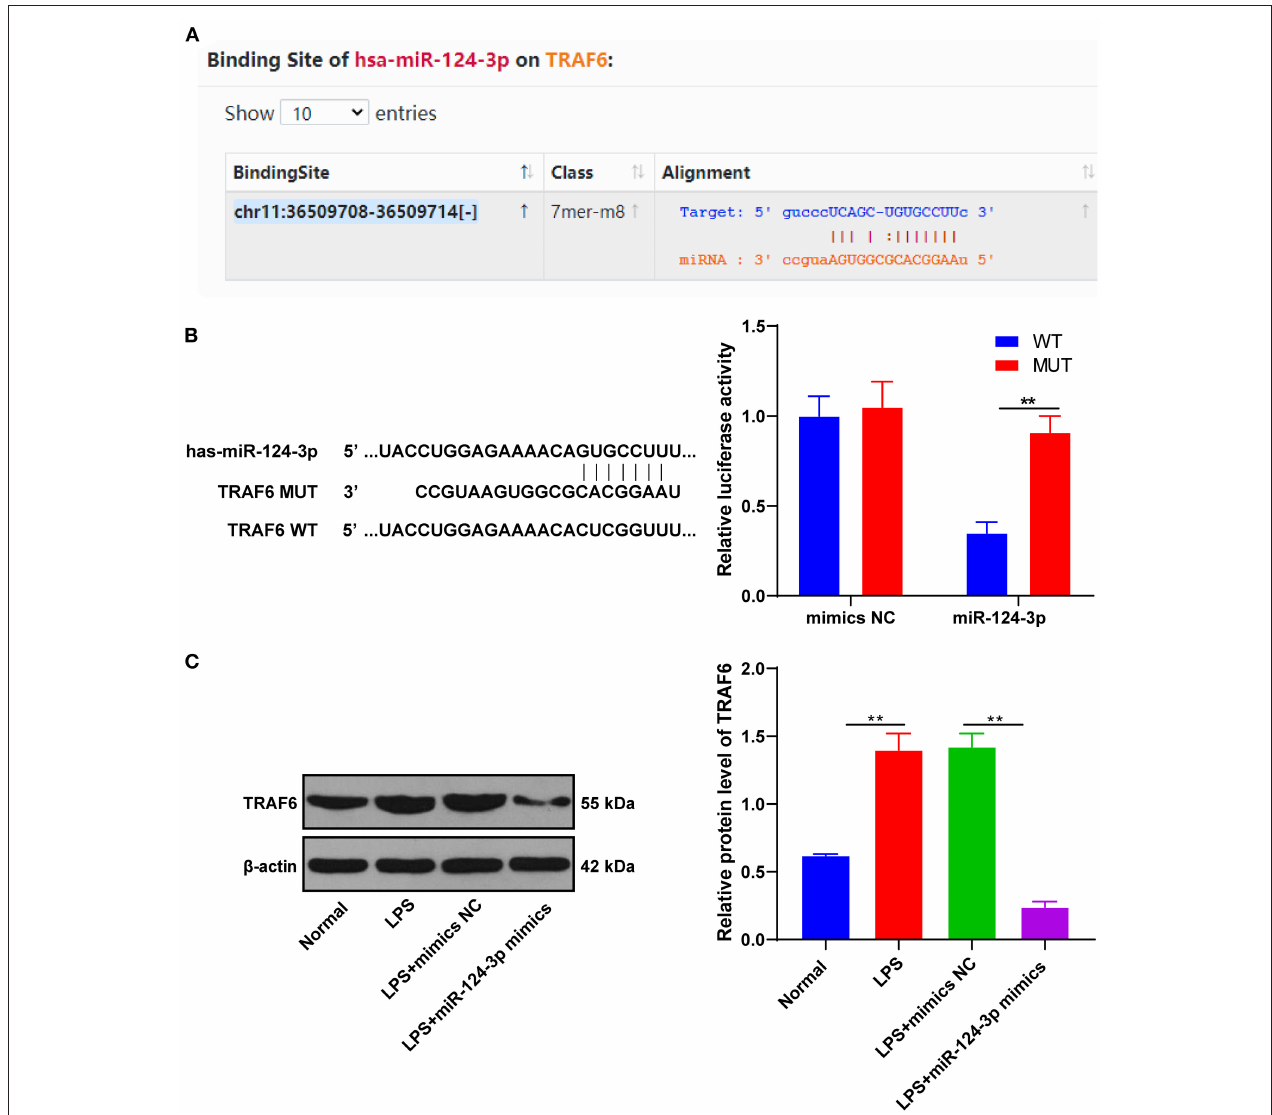
FIGURE 3 | miR-124-3p-targeted TRAF6. (A) The binding site between miR-124-3p and TRAF6 was predicted by Starbase; (B) The relative luciferase activity of miR-124-3p mimic group and mimic NC group in dual-luciferase reporter gene assay; (C) The relative expression of TRAF6 was detected using Western blotting. The cell experiments were repeated three times. Data are expressed as mean ± standard deviation and analyzed using one-way ANOVA, followed by Tukey’s multiple-comparison test, ** p <